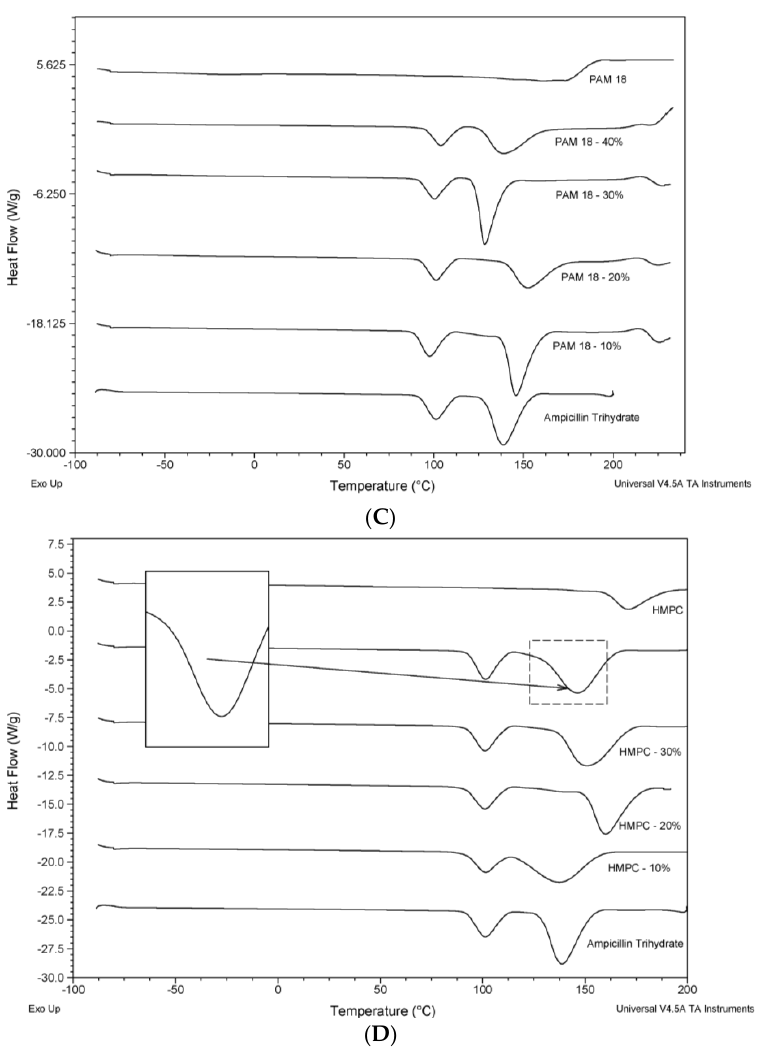
Figure 3. Thermograms of the ampicillin trihydrate blends with the polymeric materials at 10%, 20%, 30% and 40%: ( A ) PAM-4Na; ( B ) PAM-18Na; ( C ) PAM-18 and ( D ) hydroxyl-propyl-methyl-cellulose (HPMC). The endothermic signals are down.